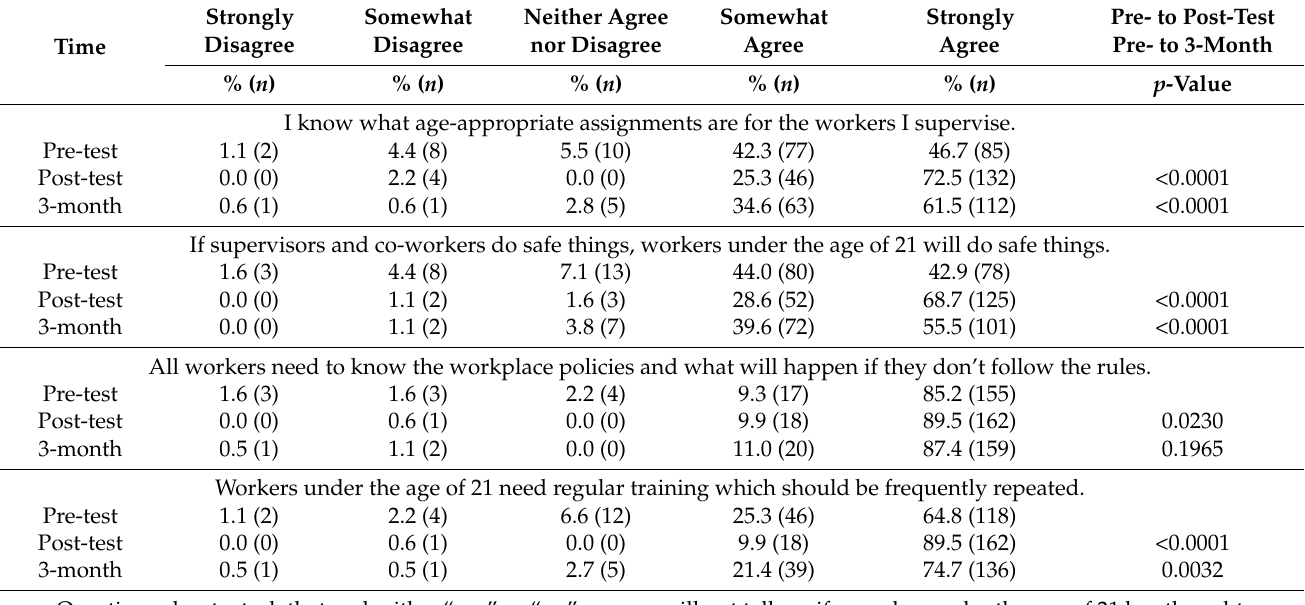
Table 4. Changes in supervisor beliefs regarding training and other behaviors they can utilize to protect younger workers and their importance over